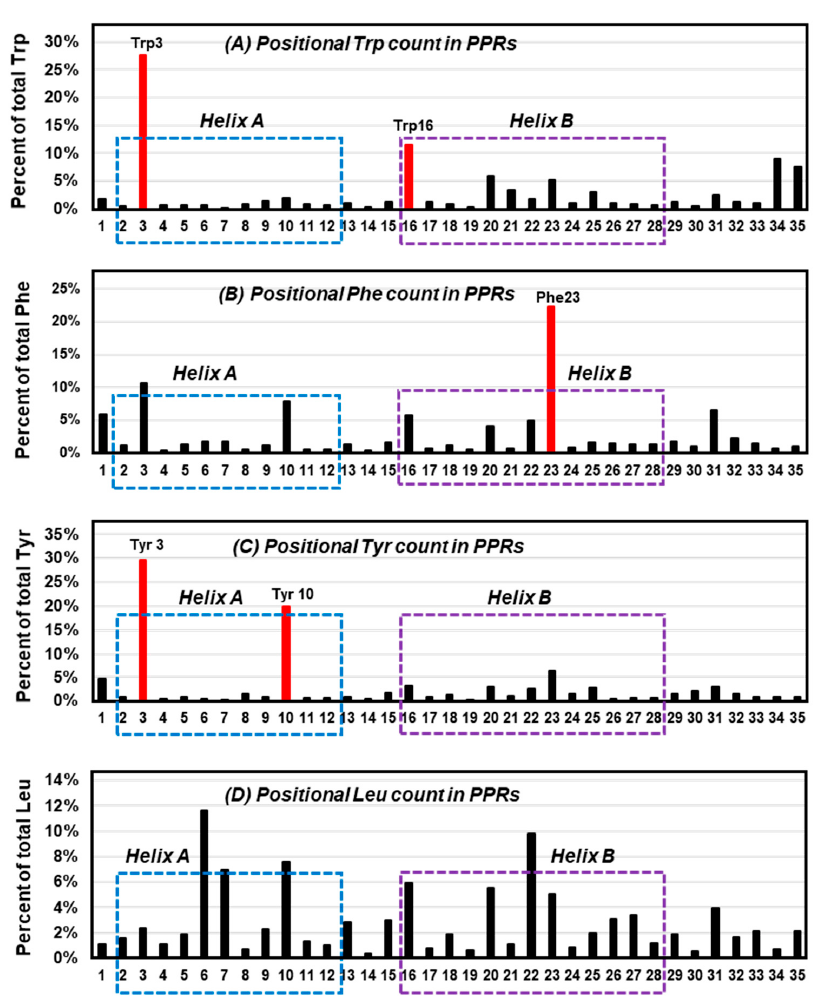
Figure 6. Locations of selected amino acids in all-helical repeats. The previously published collection of bihelical pentatricopeptide repeat (PPR) sequences [77] were visually analyzed for the location (1 to 35) of three aromatic residues, namely Trp ( A ), Phe ( B ), Tyr ( C ), and the control, nonaromatic but hydrophobic residue, Leu ( D ), and their percentage of occurrence in each position of the repeat was plotted. The most abundant location(s) of the aromatic amino acids are shown in red (Trp3/16, Phe23, Tyr3/10) and are indicated as red bars; note that Tyr3 and Trp3/16 tend to reside near the N-terminal end of the helices. Helix A and helix B [77,80] are indicated by dotted boxes, respectively, blue and purple.